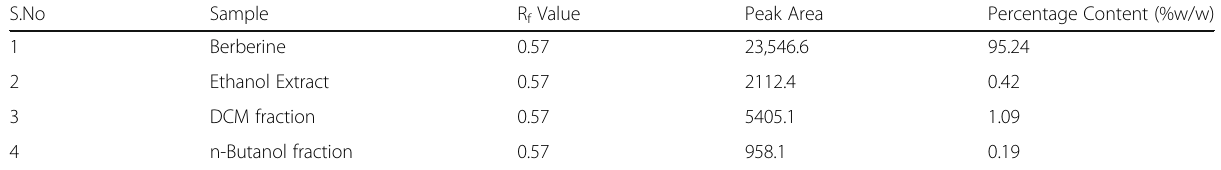
Table 5 Estimation of berberine in T cordifolia extract/fractions by HPTLC